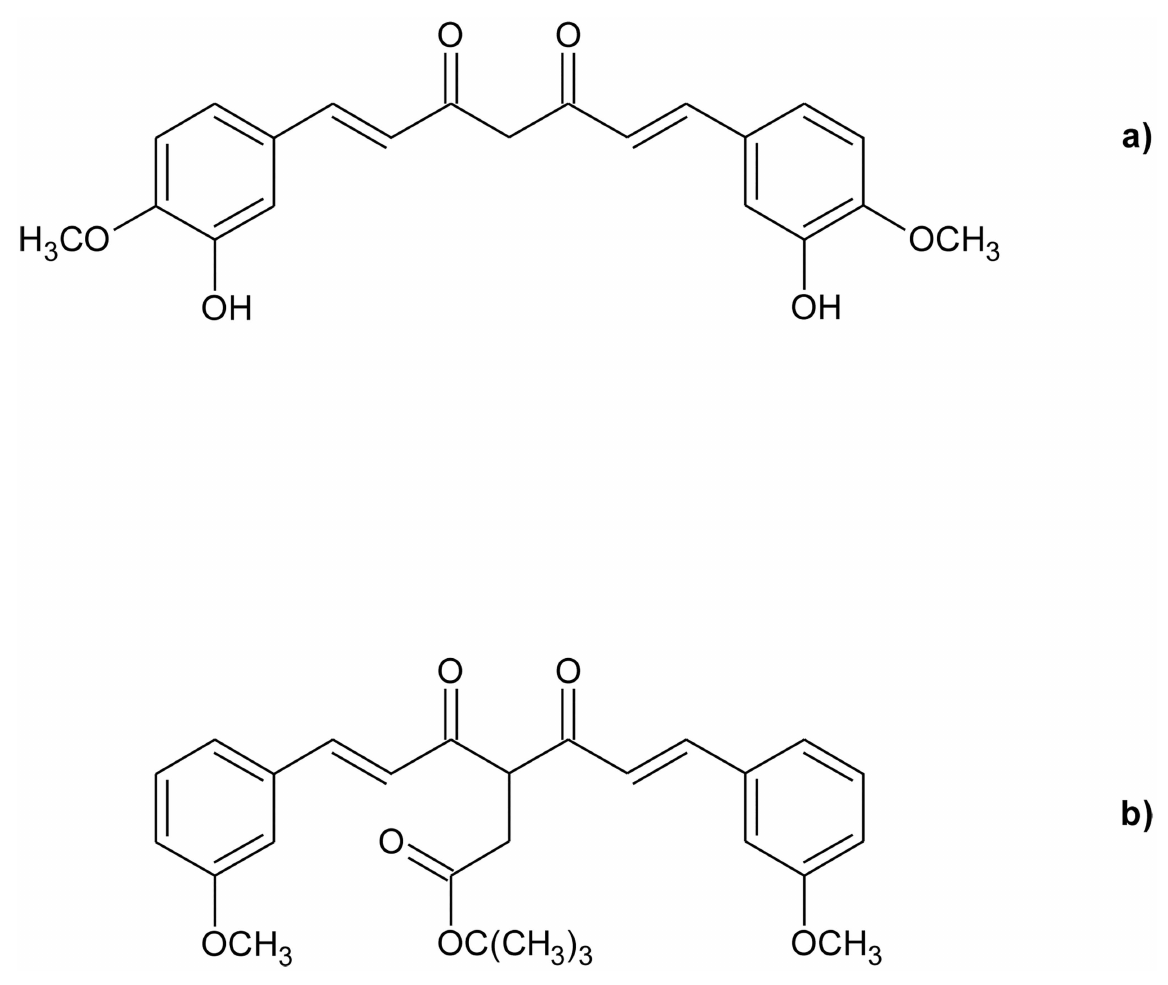
Fig 1. Curcuminoids structures. Molecularstructures of a) curcumin and b) K2T23.